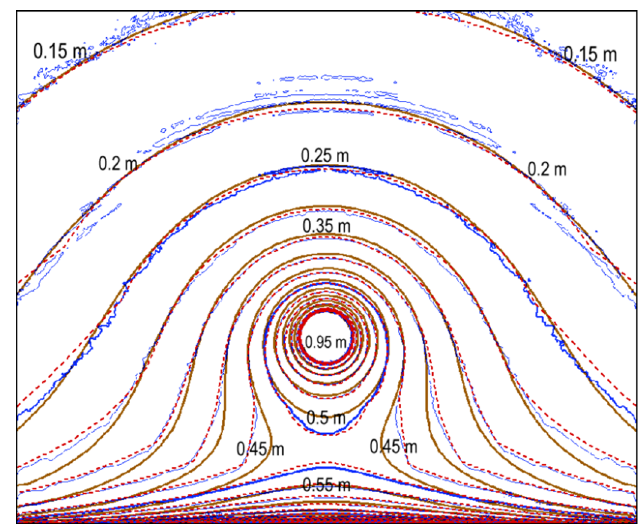
Figure 1. Isolines of maximal wave height distributions obtained by the exact solution to the shallow water system [15] (brown lines) and the numerical solutions using the field-programmable gate array (FPGA)-based “Calculator” (red dashed lines) and using the Method of Splitting Tsunamis (MOST) package (blue lines). The offshore distance is measured along the vertical axis relative to the figure’s bottom boundary.